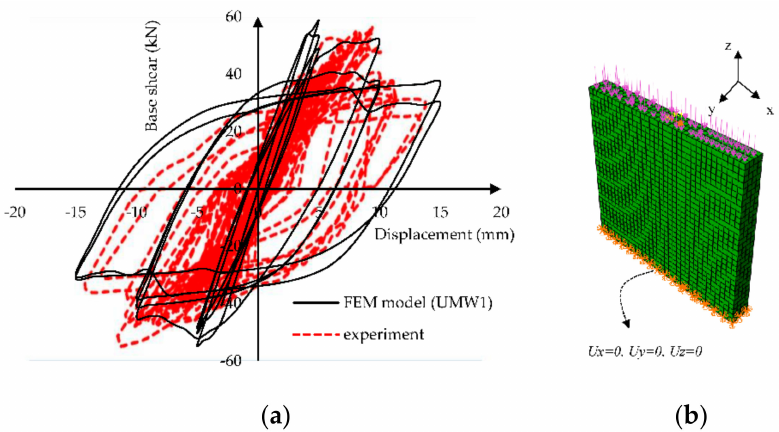
Figure 9. Verification of the finite element macroscopic model results.